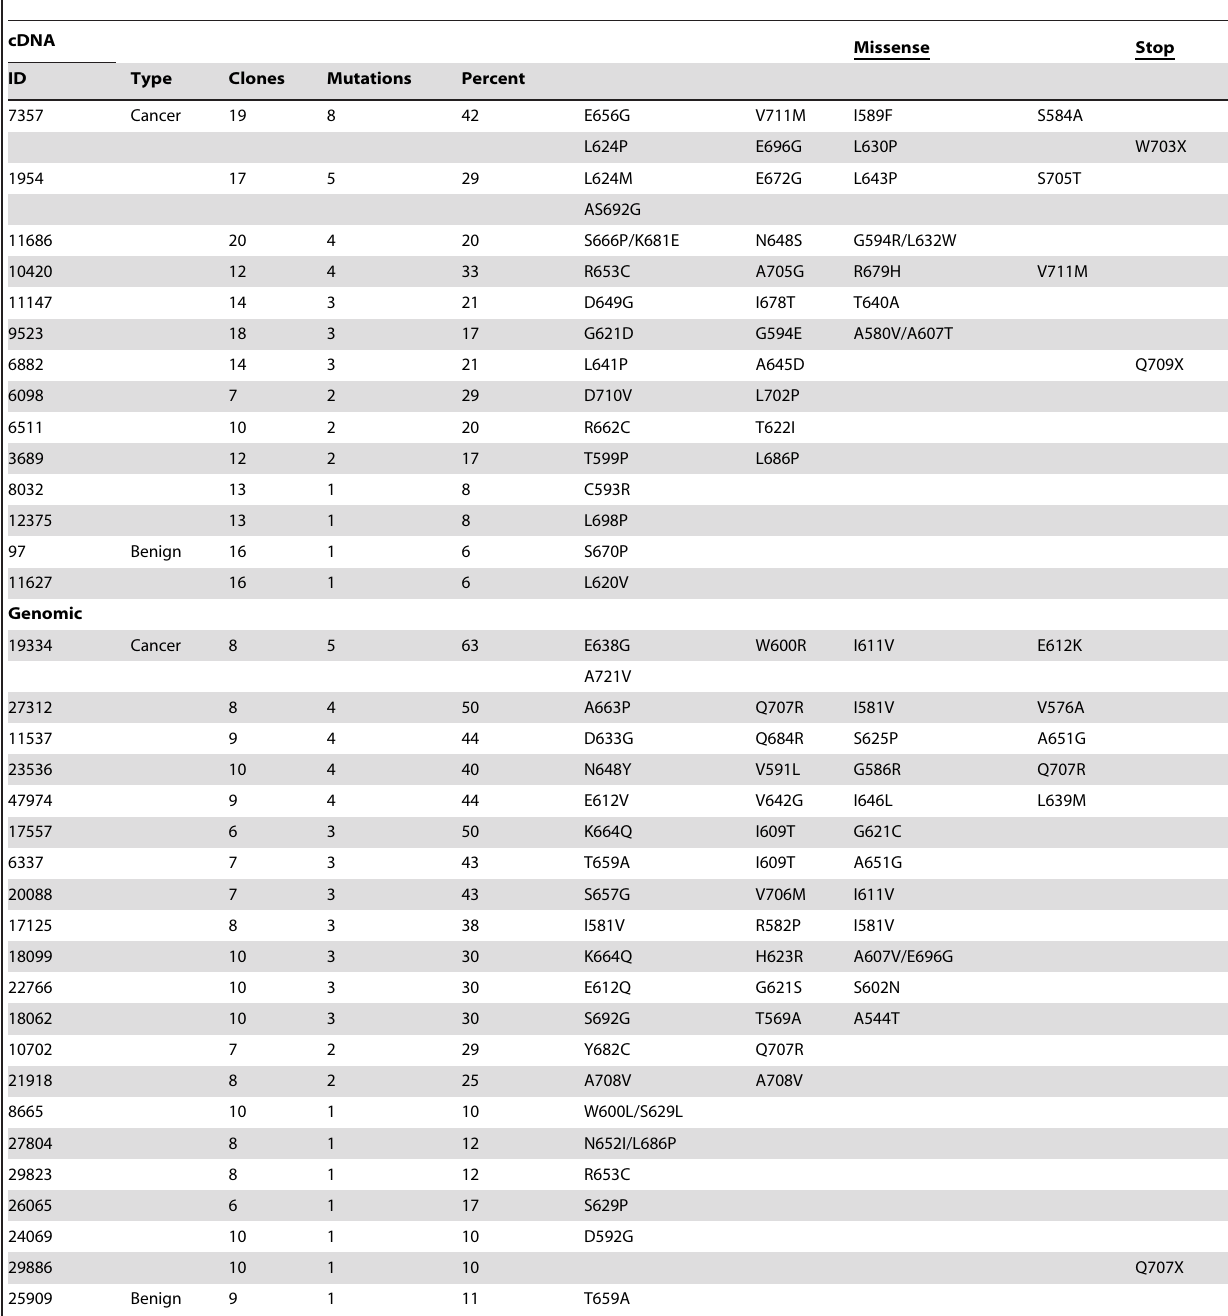
Table 1. Mutation analysis of the GAP domain of GGAP2 in prostate